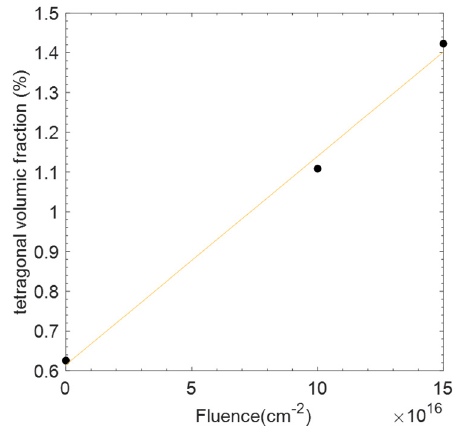
Figure 2. Fraction of monoclinic zirconia as a function of the fluence of 100 keV electrons.